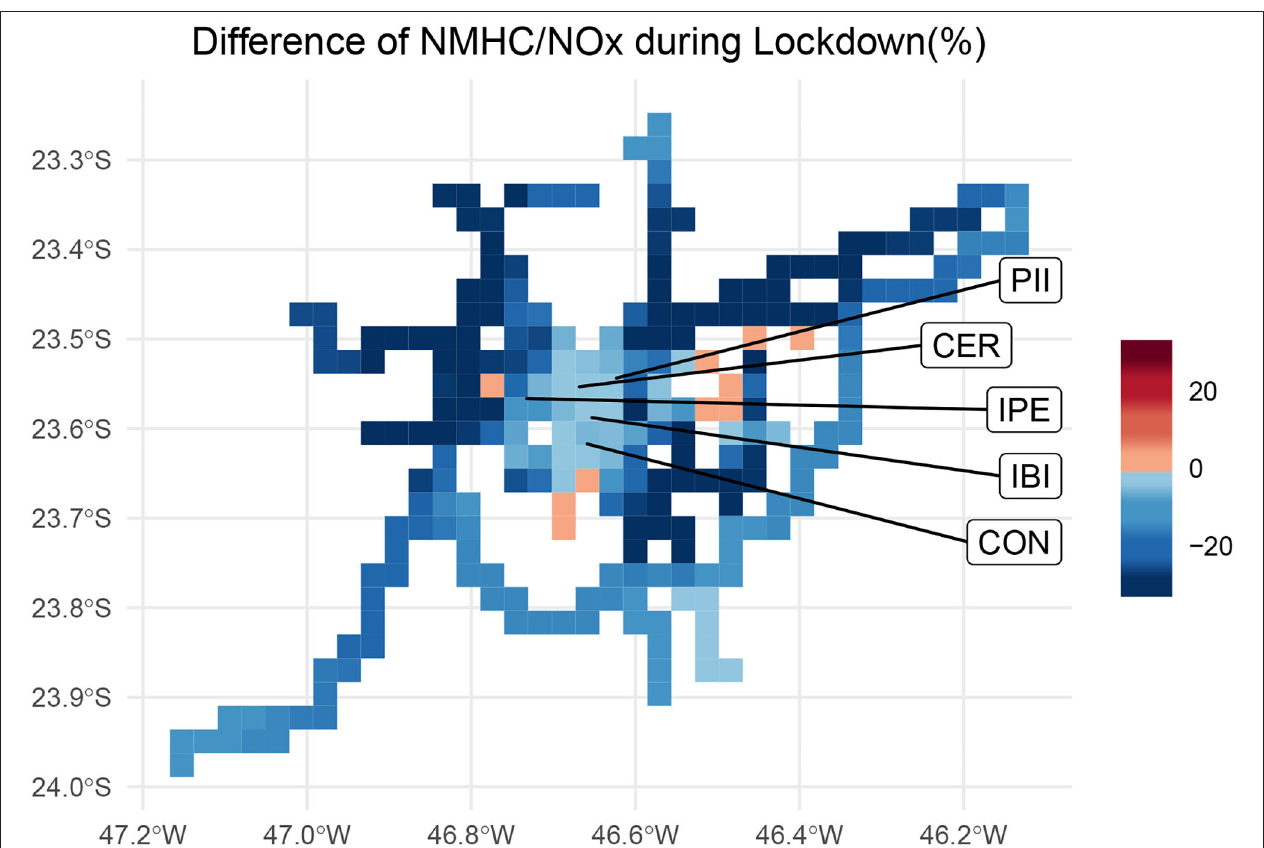
FIGURE 3 | Spatial percentage change of NMHC/NO2 between Pre-Lockdown and Lockdown in São Paulo. The location of the stations PARQUE D.PEDRO II (PII), CERQUEIRA CESAR (CER), IBIRAPUERA (IBI), and CONGONHAS (CON) is also included.